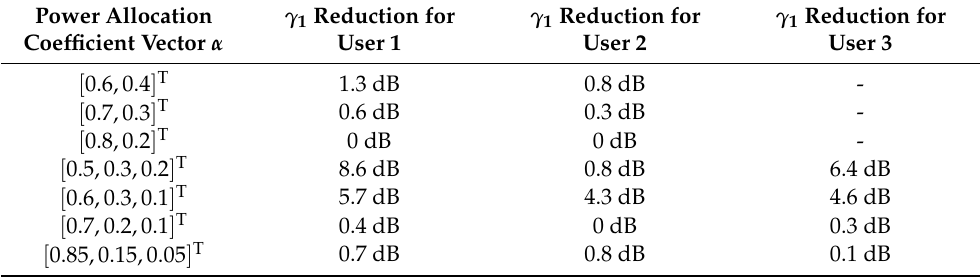
Figure 7. The sum capacity of multi-user NOMA VLC system, when K = 2 and K = 3. Table 5. The γ 1 reductions to achieve BER of 10 − 3 by using the SC-SIC-A scheme compared with SC-A scheme under various power allocation